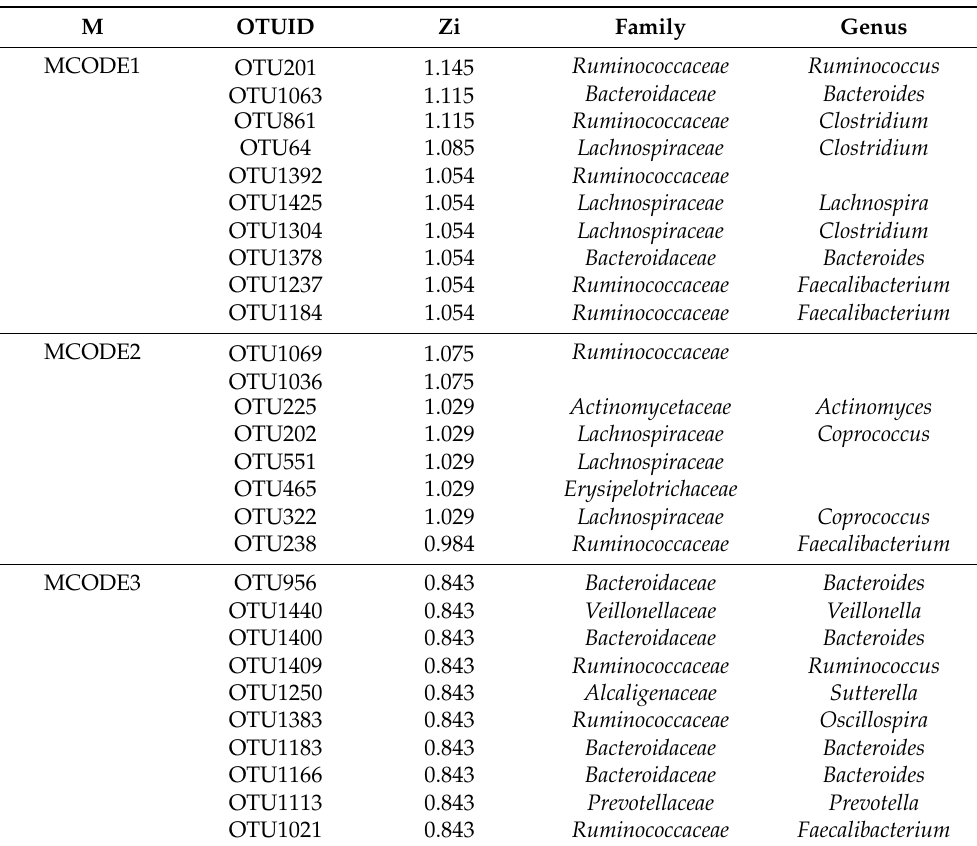
Table A10. Core colonies and corresponding Zi values in each module of M group in network